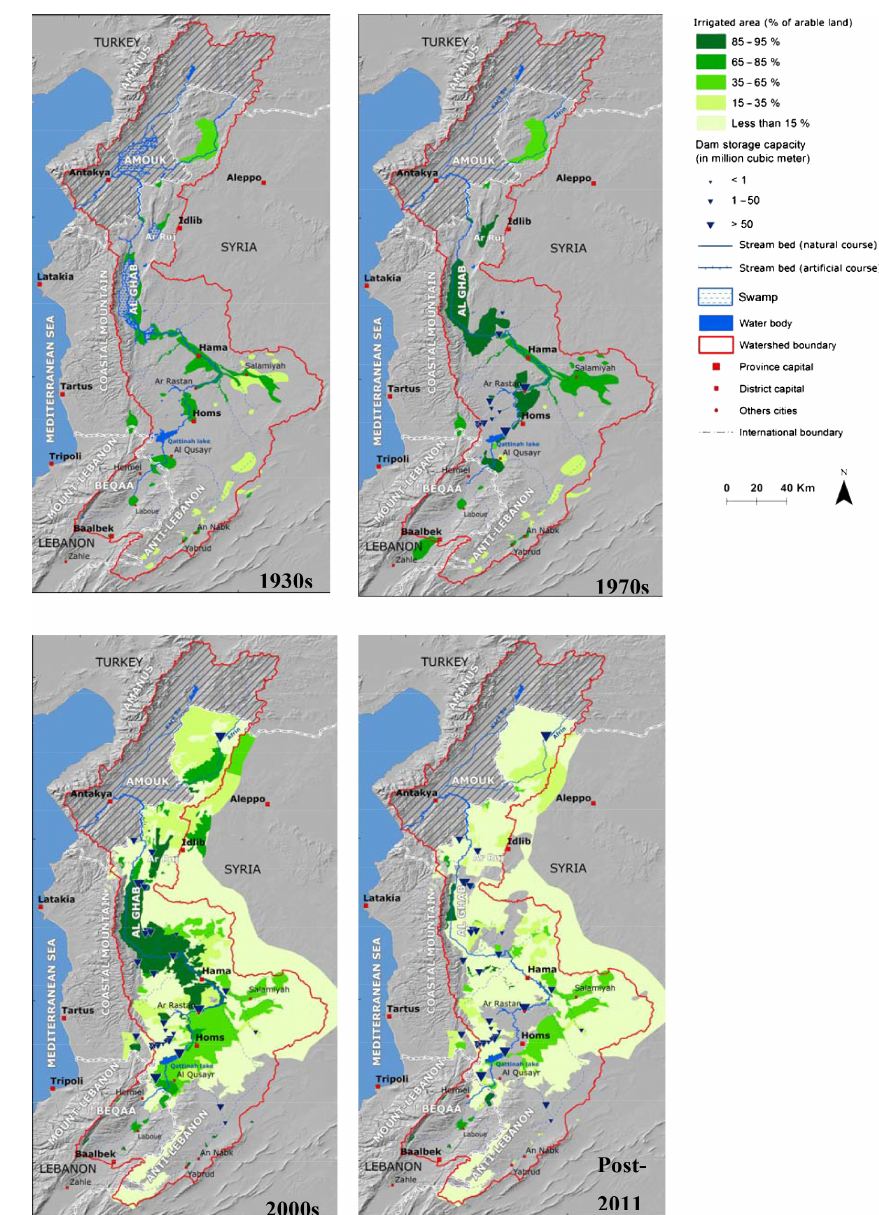
Figure 1. Evolution of irrigated areas for the 1930s; 1970s; 2010s and after 2011.